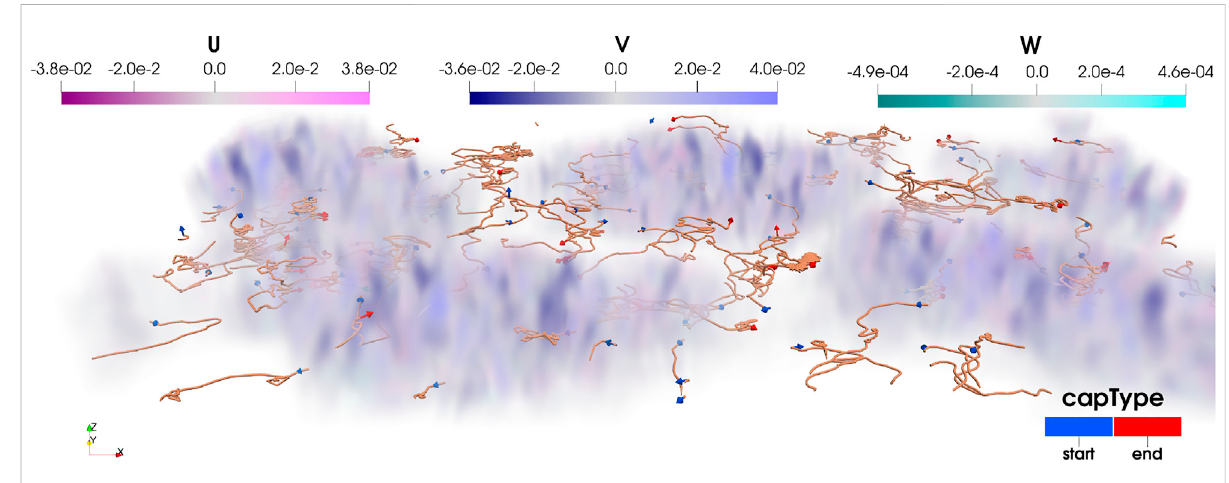
FIGURE 13 Perceptual colour mapping of Eulerian (cid:1) v and colour-indicated directed tubular Lagrangian trajectory.